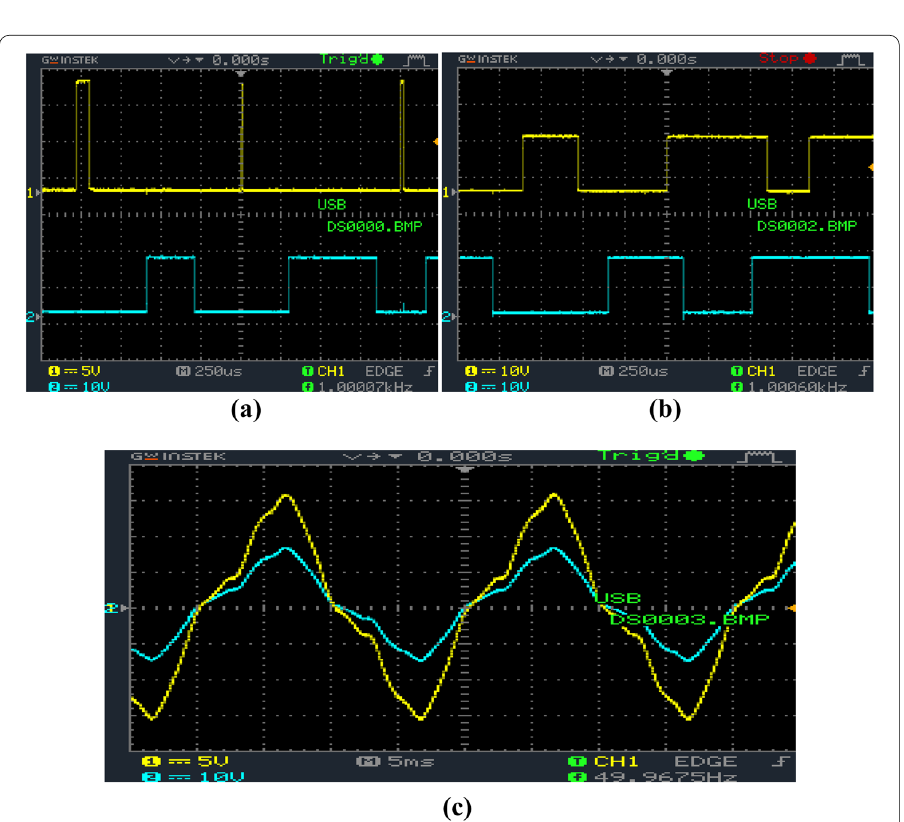
Fig. 23 Experimental waveforms of: a firing pulses of phase ‘A’; b firing pulses of phases ‘B’ & C; c Substation voltage and current